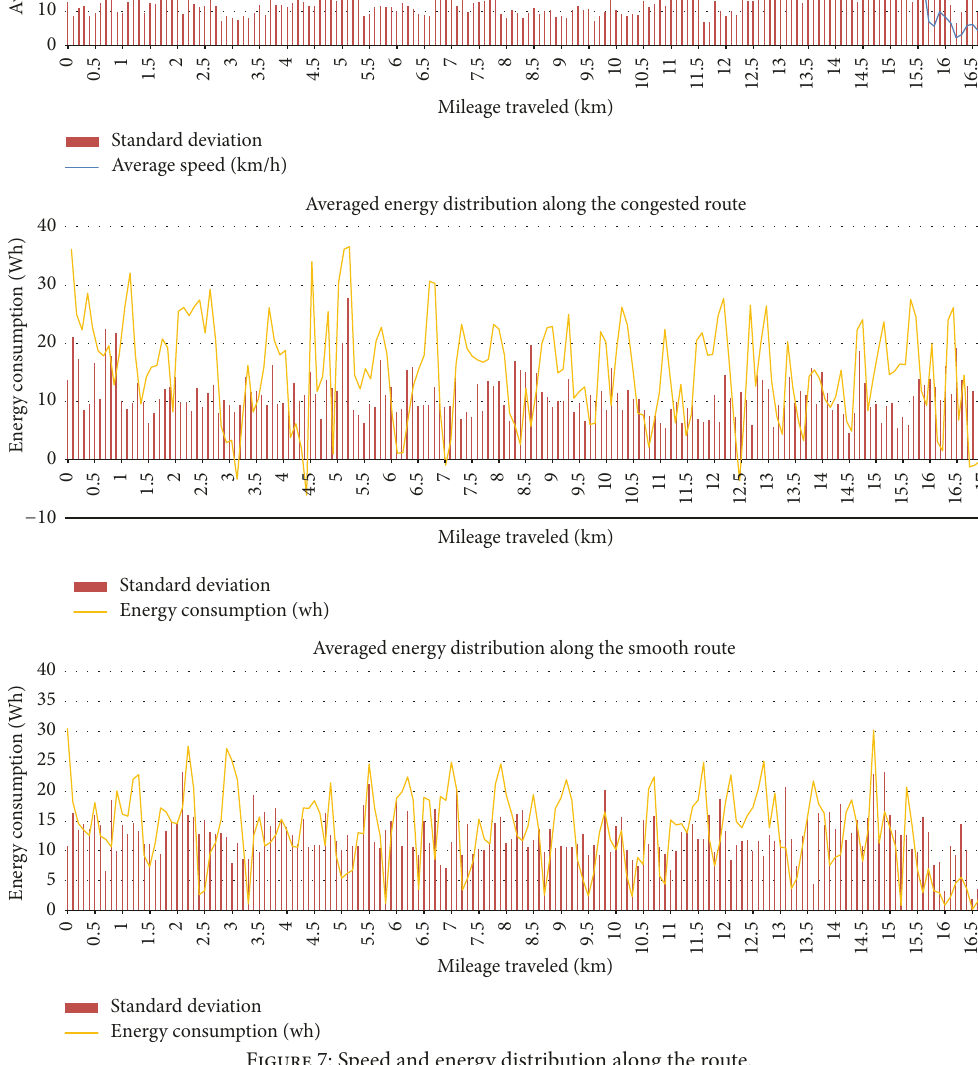
Figure 7: Speed and energy distribution along the